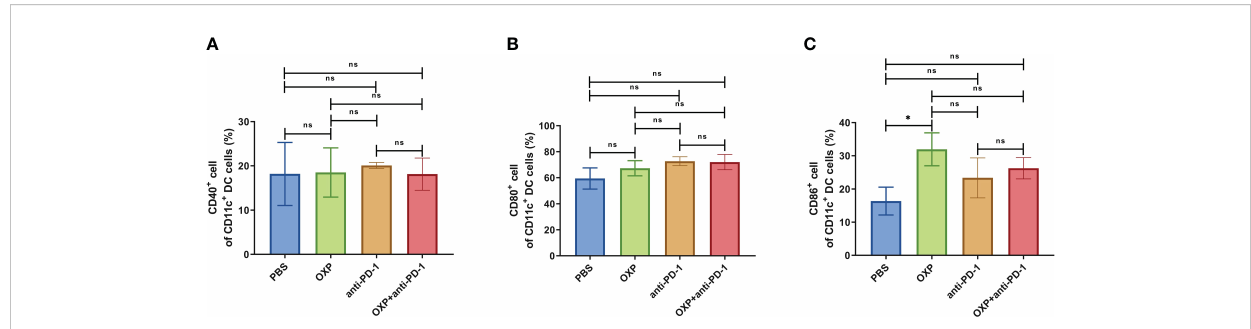
FIGURE 10 The phenotype of CD11c + DC cells in PBMC. (A) The percentage of CD40 + cells of CD11c + DC cells. (B) The percentage of CD80 + cells of CD11c + DC cells. (C) The percentage of CD86 + cells of CD11c + DC cells. ns P > 0.05, *P < 0.05.